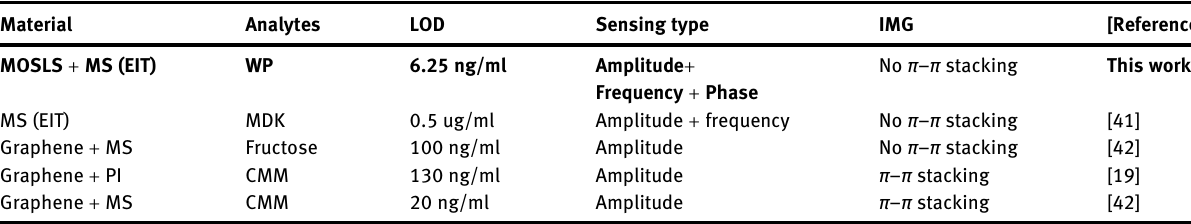
Figure 3: Experimentally measured and theoretically fitted for transmission spectra of the PGPP@MS biosensor at different CWP. (a) Experimentally measured THz transmission spectra of the PGPP@MS biosensor at different CWP. C 0 = 0 ng/mL, C 1 = 6.25 ng/mL, C 2 = 2.52 μ g/mL, C 3 = 46.8 μ g/mL, C 4 = 316 μ g/mL, and C 5 = 1.25 mg/mL). Peaks f 1 – f 5 are indicated to illustrate the sensing effect. (b) and (c) The transmission curves obtained by theoretically fi tted at each CWP for two different EIT-like frequency bands, 0.25 – 1.0 THz (b) and 0.62 – 1.58 THz (c). (d) The CWP dependence of the oscillator parameters γ 1 , γ 2 , δ , and κ , extracted by fi tting the transmission curves in (b) with Eq. (2). (e) As in (d) for the transmission curves in